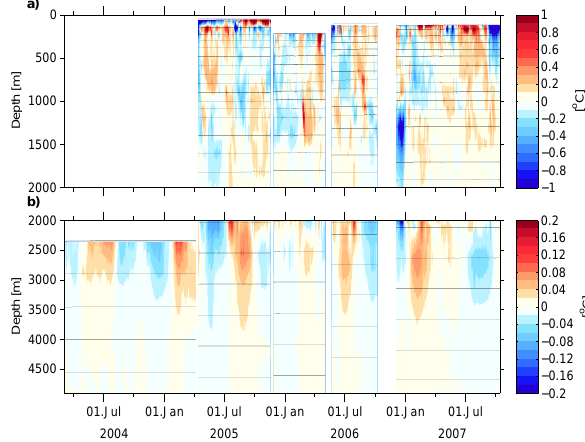
Fig. 3. 2-day low-pass filtered in-situ density anomaly at EB1, (a) from 0 to 2000m and (b) from 2000m to the bottom. Dates go from 4 March 2004 to 14 October 2007. For clarity, the anomalies computed around the time mean for each deployment period are shown. Note that panels (a) and (b) have different color scales. Horizontal lines are the levels of the measurements.